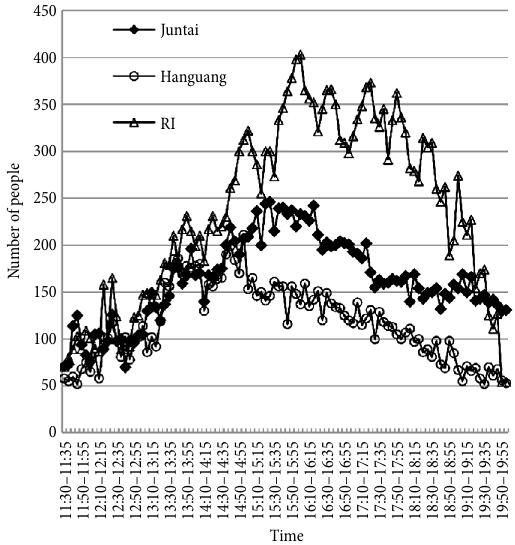
Fig. 2. Changes of the values of the related factors with time